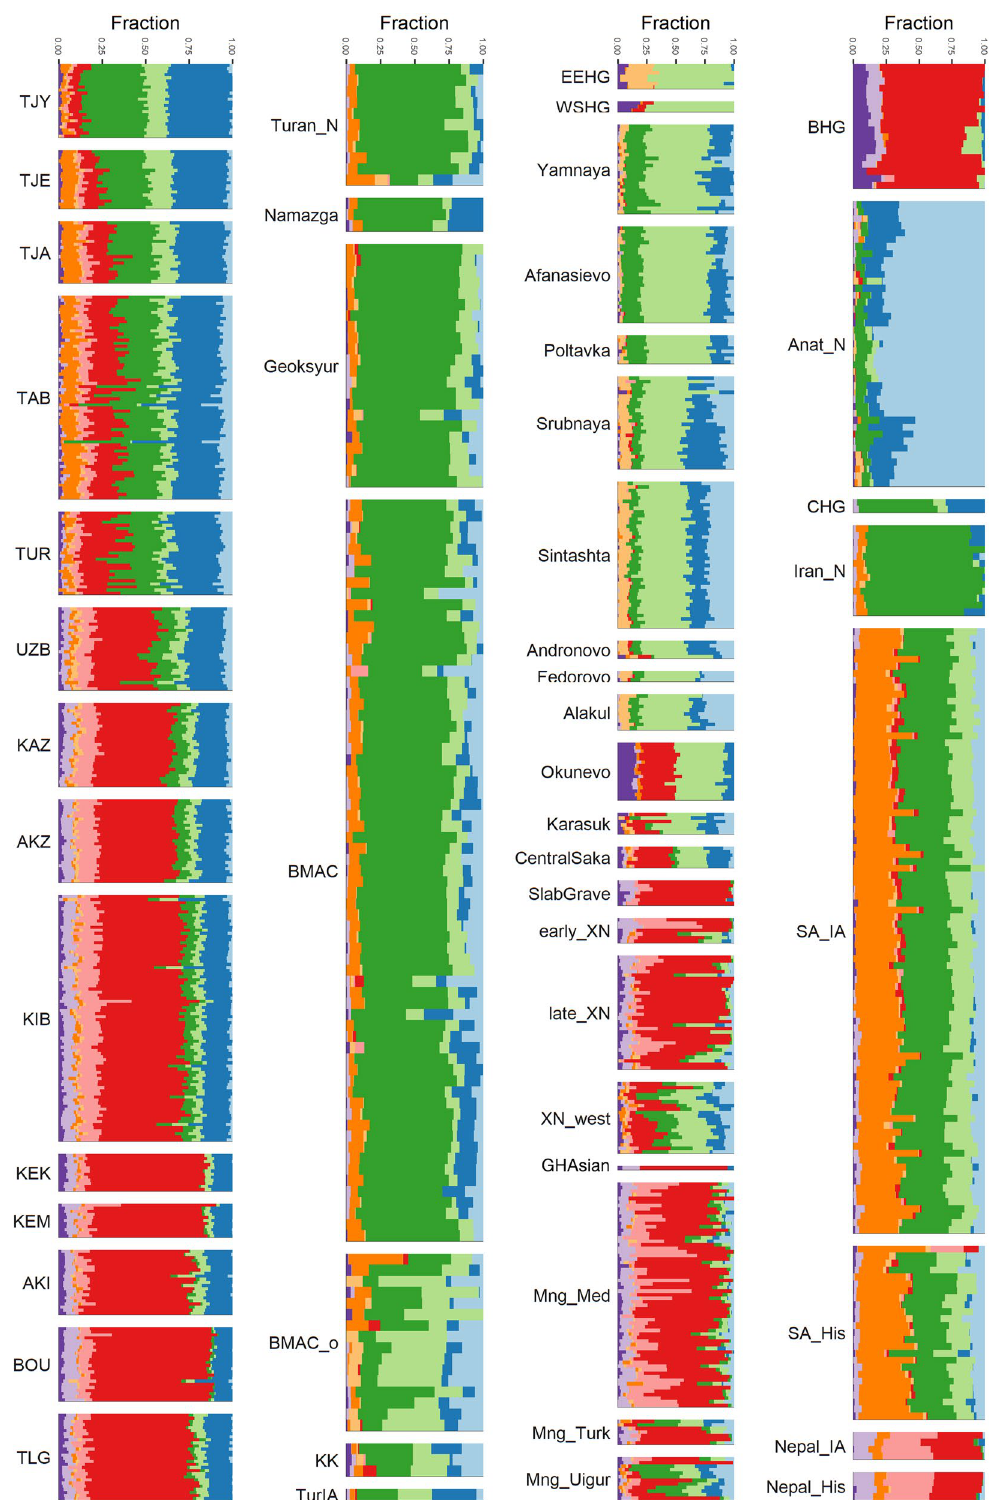
Figure 2. ADMIXTURE analysis of 5019 individuals (3102 ancient and 1915 modern). The results for a subset of the dataset (present-day Indo-Iranian individuals and ancient populations discussed in the main text) are displayed for K = 10, which has the lowest cross validation value (0.994). The full analysis is shown in SI. In the first column, the modern individuals from Central Asia; second column, the ancient individuals from southern Central Asia; third column, ancient individuals from the Steppe; last column, miscellaneous individuals discussed in the main text. (Figure done with ggplot2 v. 3.3.3 R package https:// cran.r- proje ct. org/ web/ packa ges/ ggplo t2/ index.